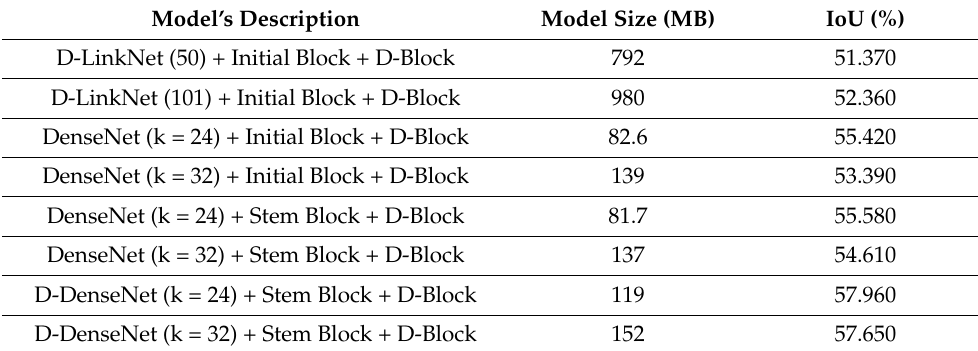
Table 1. Results on our test set of different models.